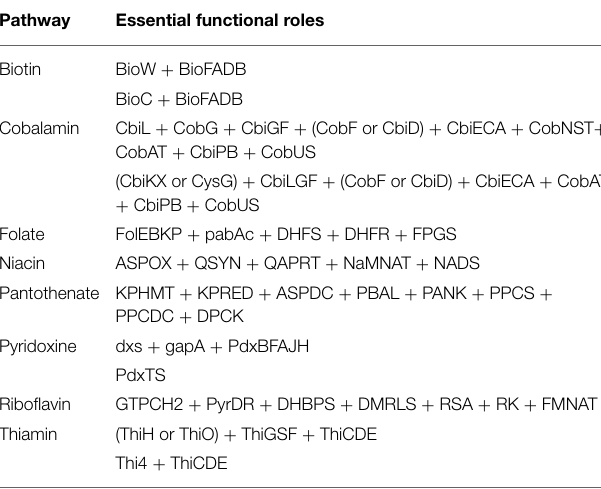
TABLE 3 | Intracellular vitamin concentrations in selected gut